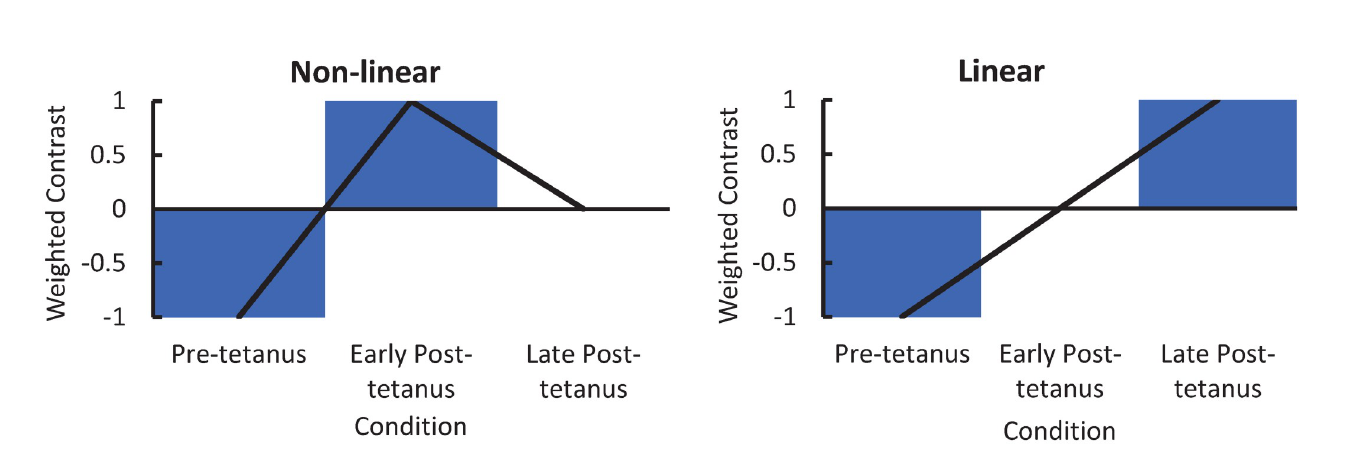
Fig 3. Contrast designs for the non-linear [–1 1 0] and linear [–1 0 1] models, where the combination is modelled as having a non-linear and linear contribution [-1 1 0; -1 0